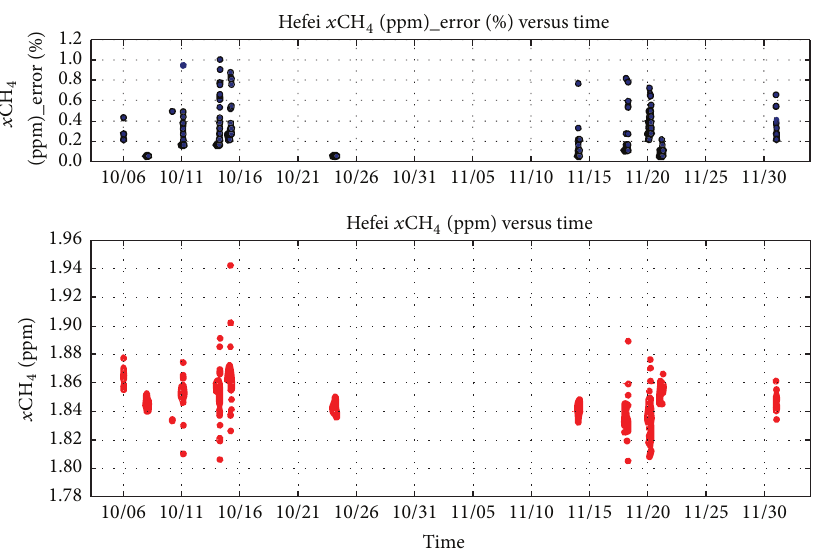
Figure 9: DMF time series ranging from October 6, 2014, to December 1, 2014, which are calculated according to VCD CH 4